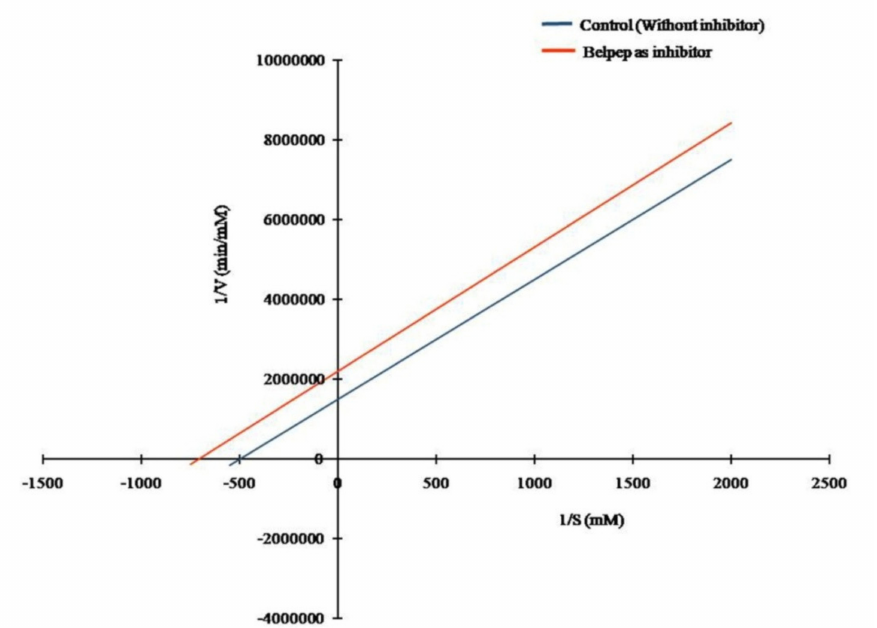
Figure 4. ACE inhibitory kinetics of the peptide isolated from ultrafiltered 3 kDa permeates of Bel- lamya bengalensis protein alcalase hydrolysate. Lineweaver–Burk plot of ACE inhibition by the peptide isolated from ultrafiltered BBPH A120 . The ACE inhibitory properties were evaluated both in presence and absence of inhibitor. Here, 1/[S] and 1/V represent the reciprocal substrate concentration and velocity of the reaction, respectively.